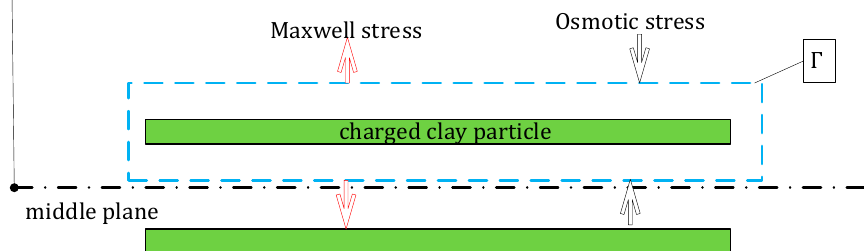
Figure 1. Electrostatic stresses felt by charged clay particle in electrolyte solution.